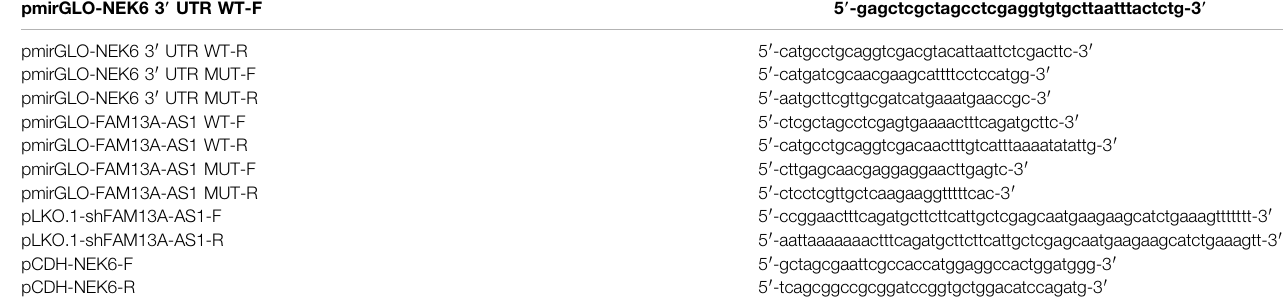
TABLE 2 | Primers for plasmid construction.